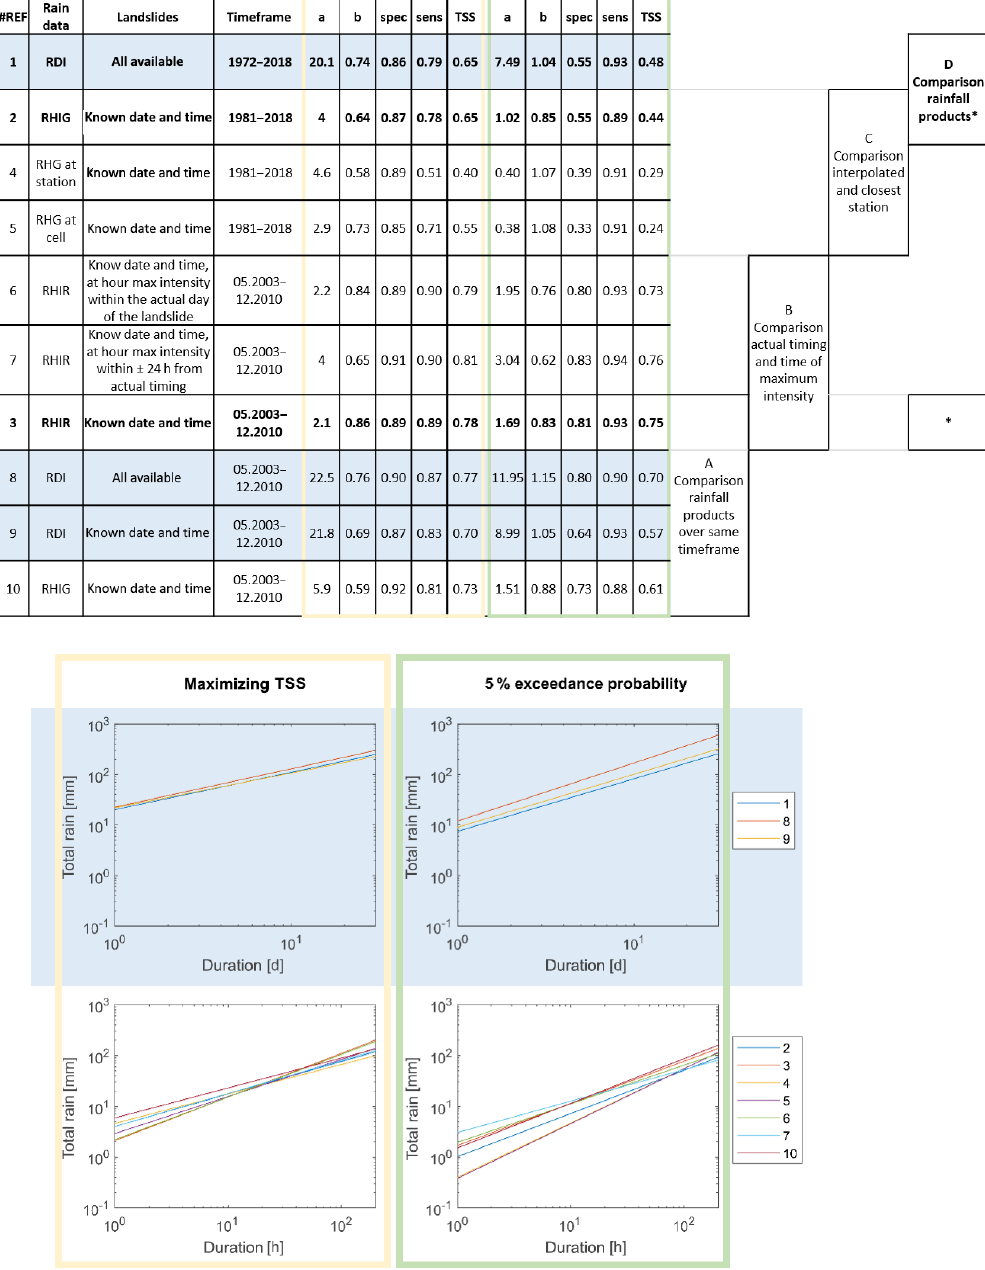
Figure 2. Table containing the coefficients of the threshold power law curve in the total rainfall–duration plane obtained by maximising the TSS, or selecting the 5% exceedance probability line following the frequentist approach, for all the different time frames and rainfall records. To facilitate reading, the different comparisons carried out are indicated, matching the respective results. In the bottom panel, all the ED threshold curves are shown, separated into daily (above) and hourly (below), obtained with TSS maximisation (left) or following the frequentist approach (right). The numbers in the legend match the “#REF” entry in the Table